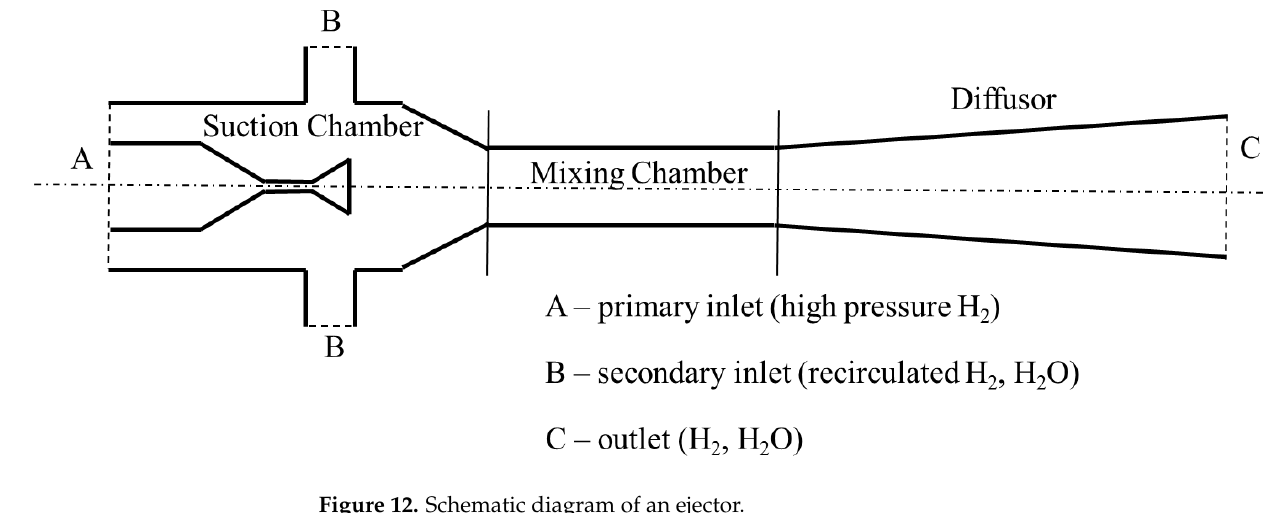
Figure 12. Schematic diagram of an ejector.